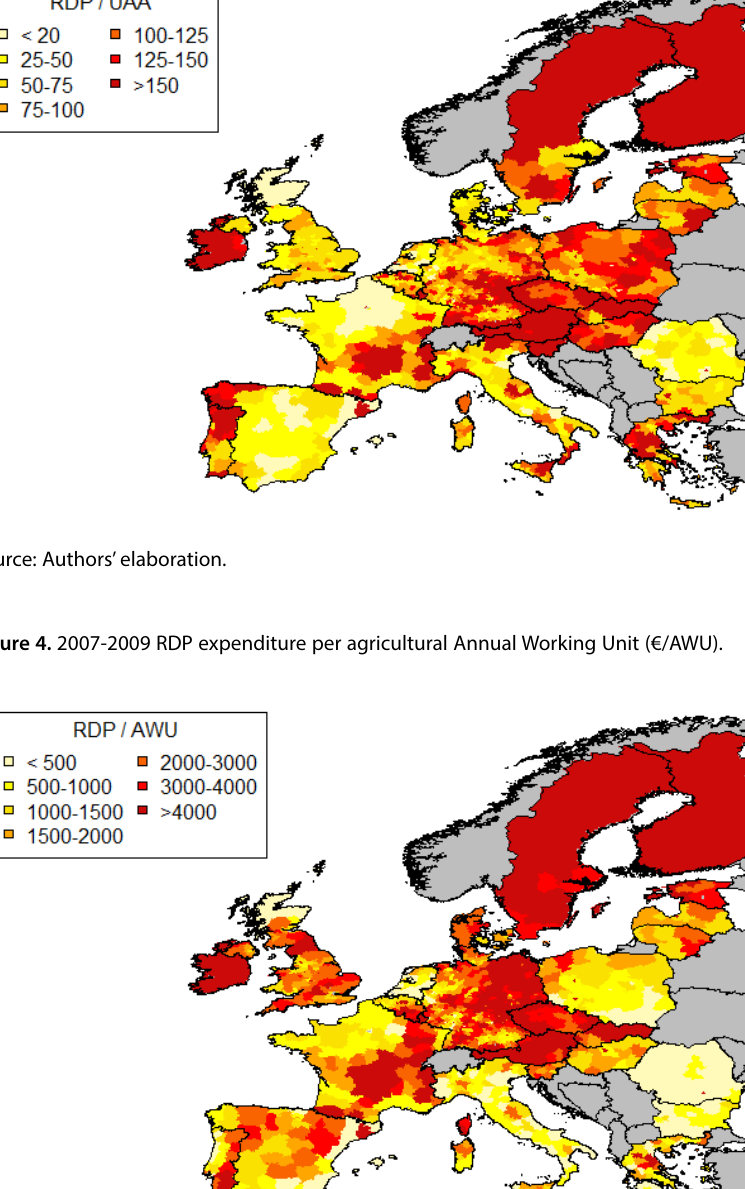
Figure 3. 2007-2009 RDP expenditure per unit of Utilised Agricultural Area (€/UAA).